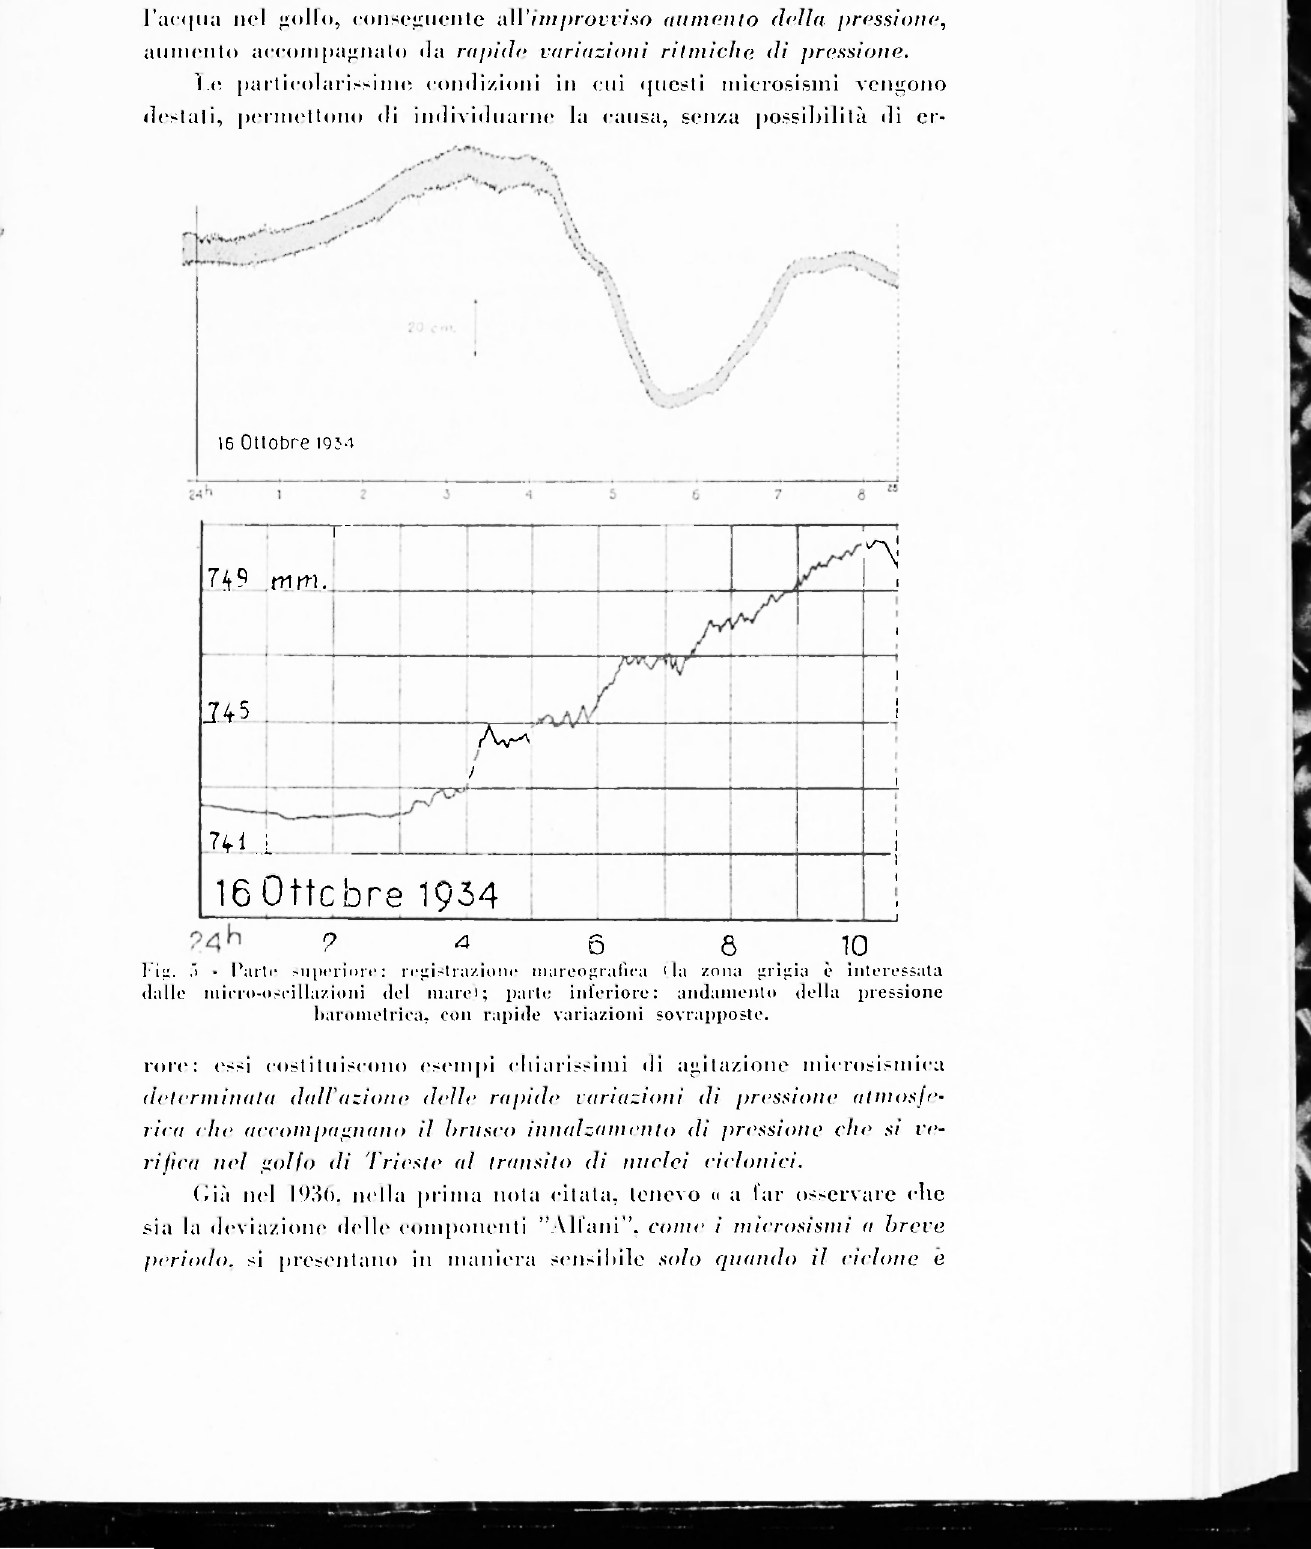
barometrica, con rapide variazioni